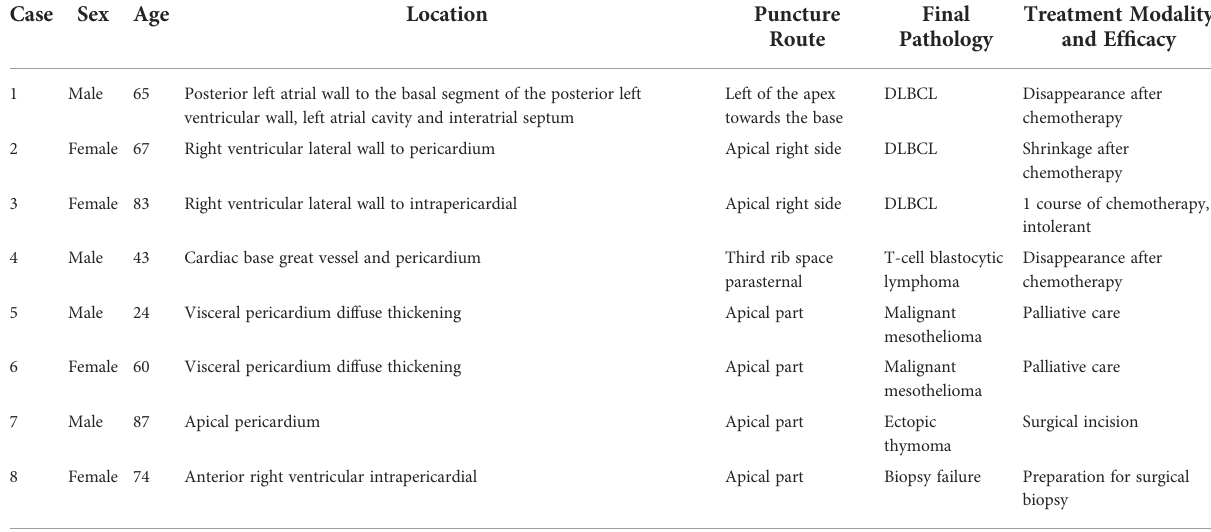
TABLE 1 Clinical data of PUS-CNB of cardiac tumors.